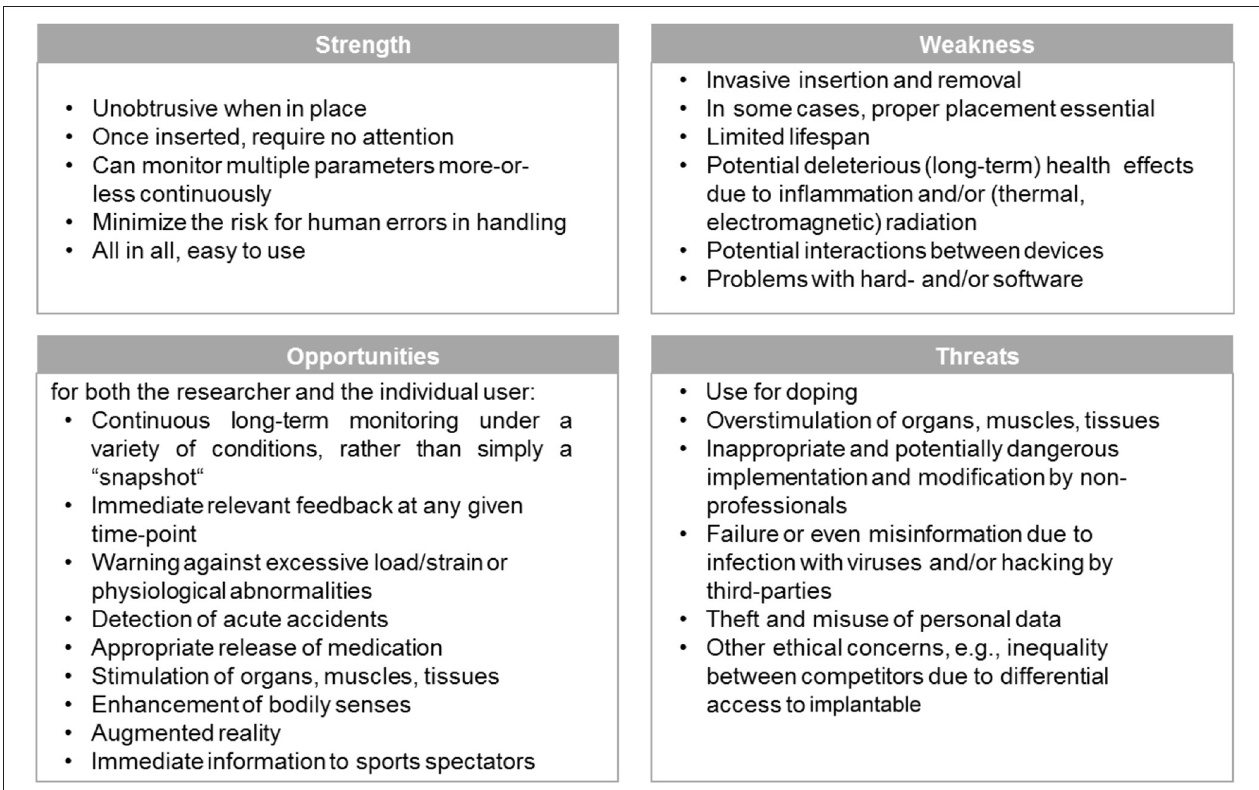
FIGURE 1 | SWOT matrix for identifying the strengths and weaknesses, as well as opportunities and threats of